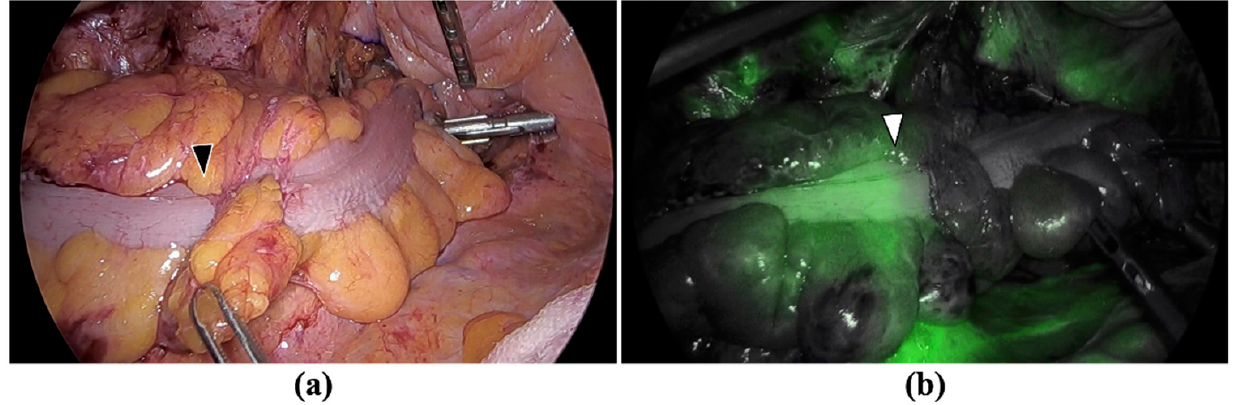
Figure 1. Perfusion assessment of colonic stump with ICG-FA: ( a ) Observation under white light just before anastomosis. There appears to be no difference in the coloration of the intestine between the oral and anal sides of the black arrowhead; ( b ) Observation with the NIR camera after ICG injection revealed that there was no vascular perfusion on the anal side from the white arrowhead.